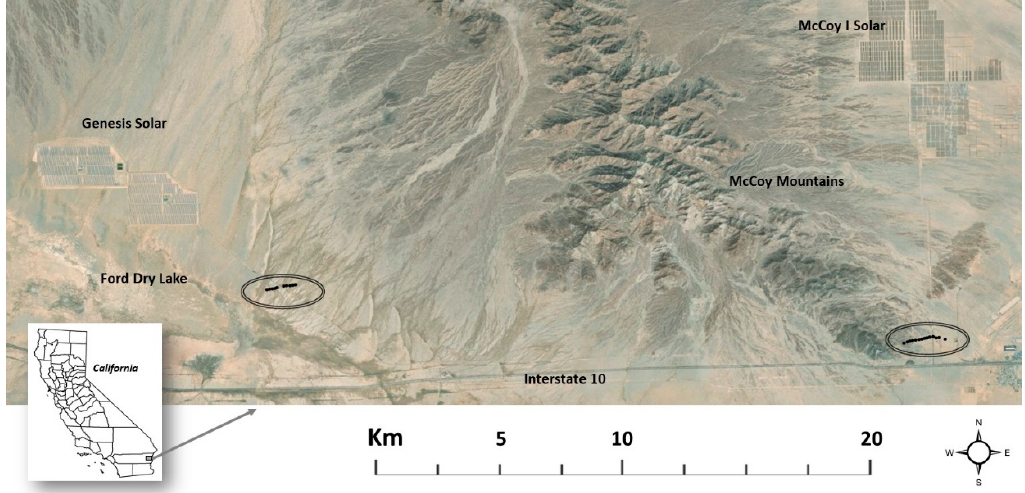
Figure 1. Transect locations of temperature measurement stakes (black dots within circles) in eastern Riverside County, California. The southern McCoy Mountains are to the right center on the true-color satellite image, while Ford Dry Lake is on the western-most section of the study area map.